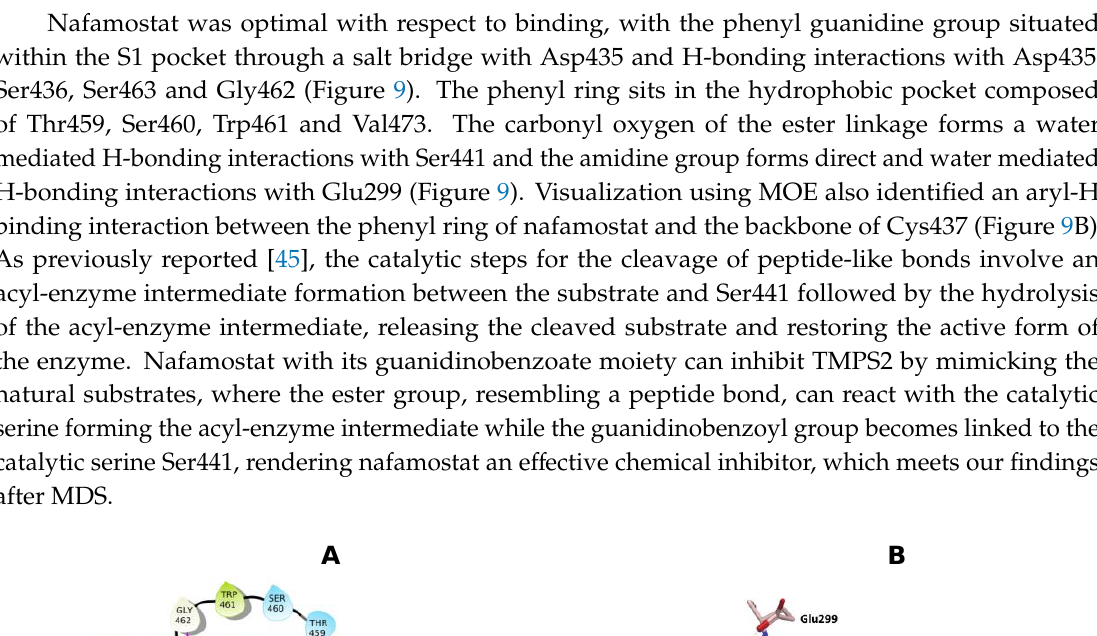
Table 4. Protein-ligand RMSD (Å) at 0 and 200 ns.